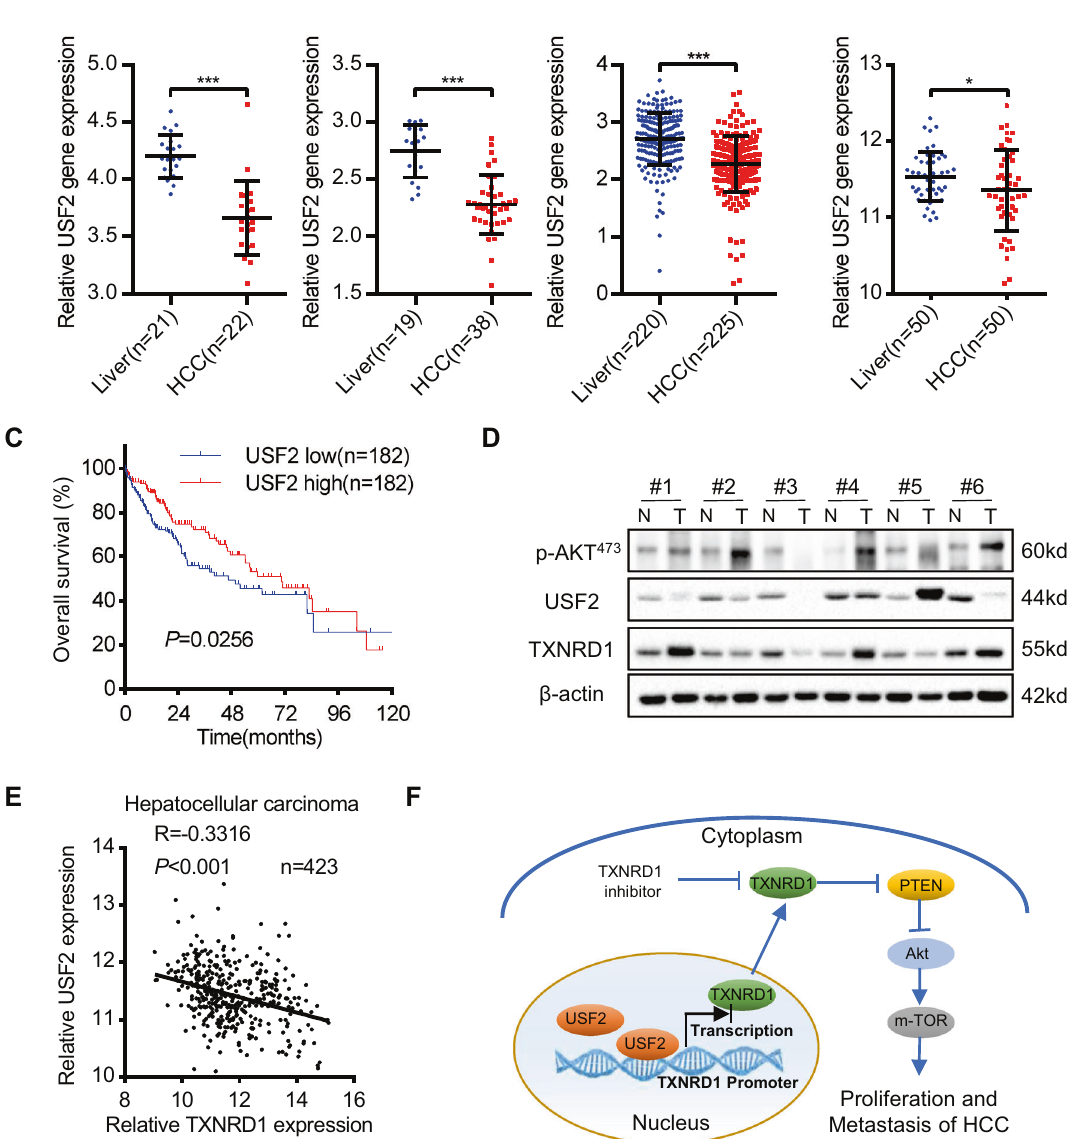
Fig. 7 USF2 is downregulated in HCC and negatively associated with TXNRD1 expression. A Dot density plots show USF2 mRNA level in normal or tumorous HCC samples determined by microarray analysis. Different datasets from the Oncomine database were analyzed. B USF2 expression in 50 paired samples of tumorous tissues and nontumorous adjacent normal liver tissues from patients with HCC in TCGA cohort. C Kaplan-Meier analysis for overall survival was performed according to USF2 levels in TCGA cohort. D Protein levels of p-Akt, USF2 and TXNRD1 were examined by western blot analysis in six paired samples from patients with HCC. E Dot plot showing the correlation between the mRNA levels of TXNRD1 and USF2 in the TCGA LIHC panel. F Schematic depiction of mechanisms underlying USF2-mediated upregulation of TXNRD1 contributes HCC proliferation and metastasis via Akt/mTOR activation. Data represent the mean ± SD. * P < 0.05, *** P < 0.001. P values were calculated by Student ’ s t test ( A ), Paired t test ( B ), log-rank test ( D ), Pearson ’ s correlation coef fi expression of TXNRD1 was observed in HCC and related to poor prognosis. Besides, our data proved that TXNRD1 enhanced the proliferation and metastasis of HCC cells in vivo and in vitro, demonstrating that TXNRD1 promoted HCC progression. It should be emphasized that the two opposing roles of TXNRD1 in cancers, prevention/promotion, is not paradoxical. TXNRD1 functions as maintaining redox homeostasis and decreasing the mutation of normal cells that lead to cancer. Malignant cells often display upregulation of cellular antioxidant systems and exhibit stronger reliance on antioxidant systems counteracting the ROS overproduc-